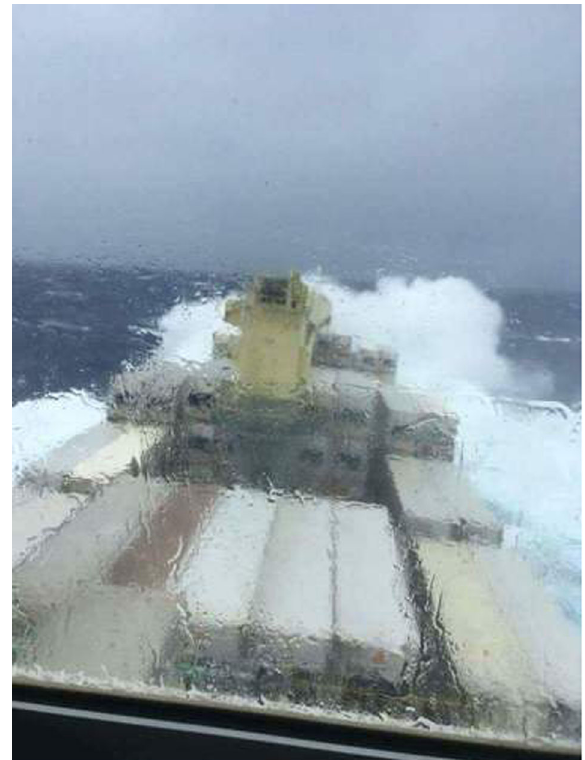
Fig. 2 Tropical Storm. Photograph taken by a participant of waves coming over the